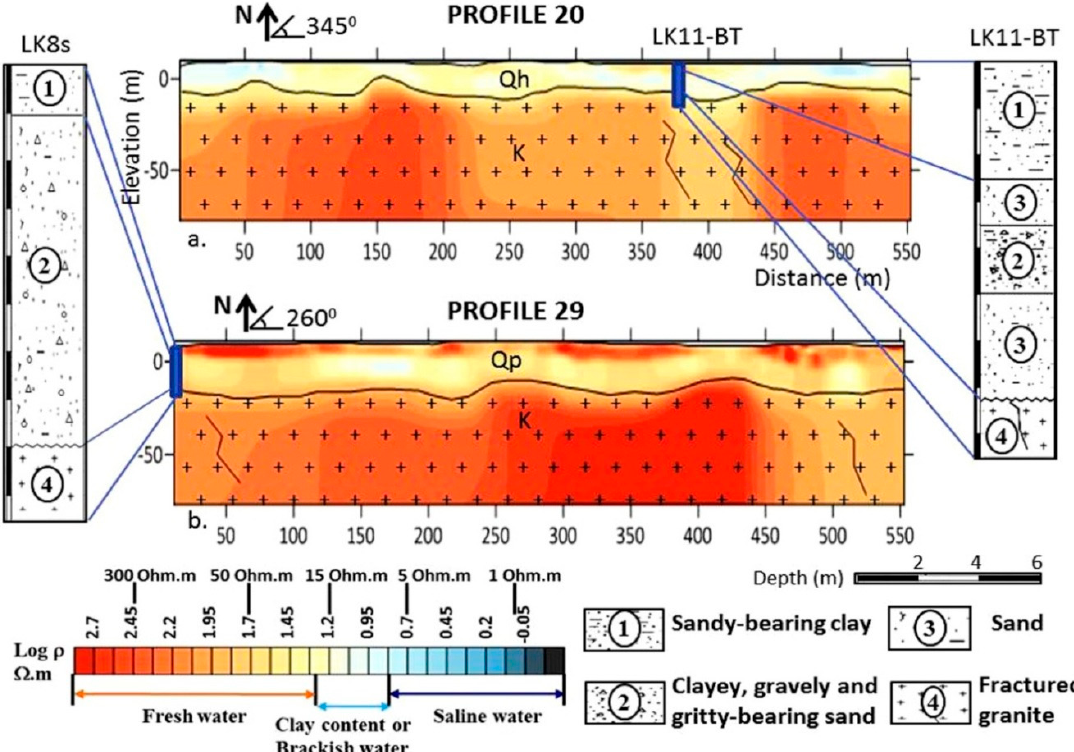
Figure 4. Relationship between resistivity and the lithological composition of boreholes. The low resistivity features are characterized by higher clay content in both saturated and fractured zones. Note that Qh, Qp are Holocene and Pleistocene aquifers, respectively; K refers to Deo Ca Cretaceous granite complex. The same notation is used in the following figures.